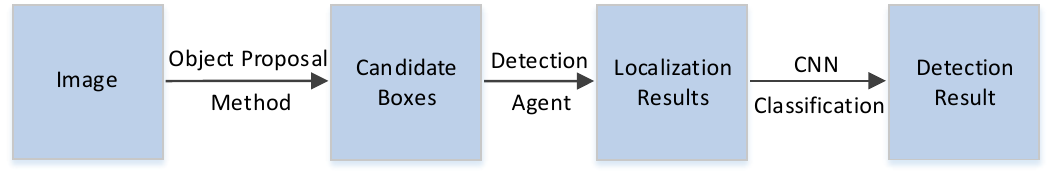
Figure 1. Reinforcement learning and CNN (RL-CNN) aircraft detection